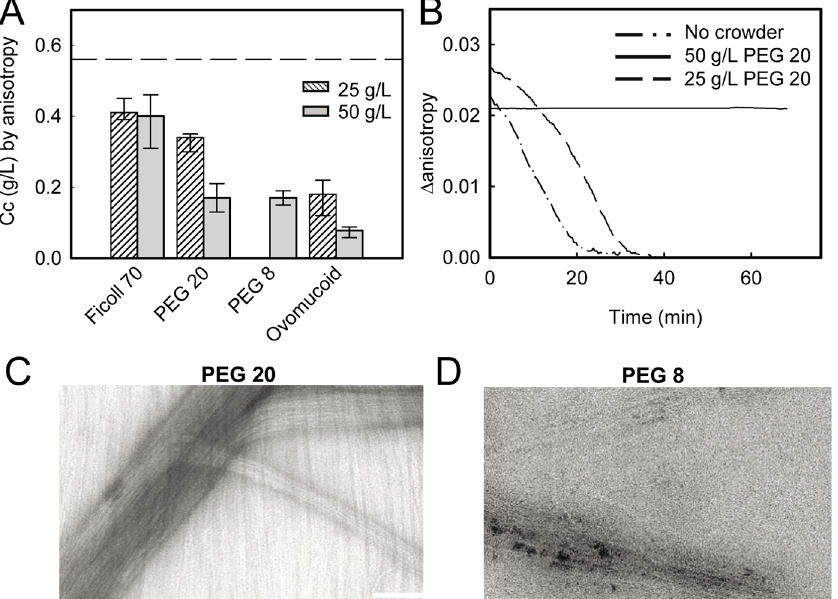
Fig 4. Effect of non-inert polymers on FtsZ polymerization. (A) Cc values ± SD determined with the specified crowders. Dashed line depicts the Cc value in the absence of crowder. (B) Effect on the depolymerization kinetics of FtsZ (1.5 g/L) of PEG 20. Profile in the absence of crowder is shown for reference. (C) and (D) EM images of GTP-FtsZ polymers in the presence of PEG 20 and PEG 8,